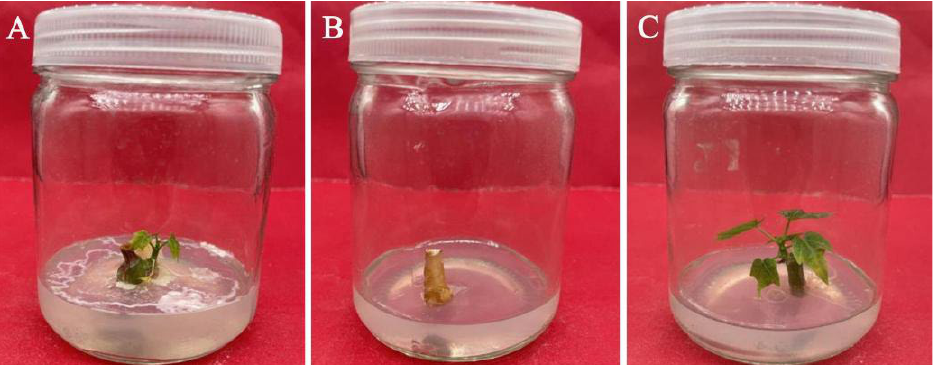
Figure 1. Performance of sterilization on C. aconitifolius stem segment explants. ( A ) Contaminated stem segment explants; ( B ) uncontaminated but dead stem segment explants; and ( C ) uncontaminated and surviving stem segment explants.